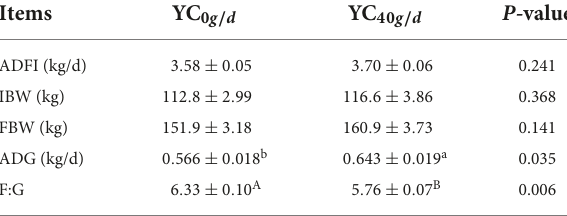
TABLE 2 Effect of feeding YC on growth and feed efficiency of growing bulls.